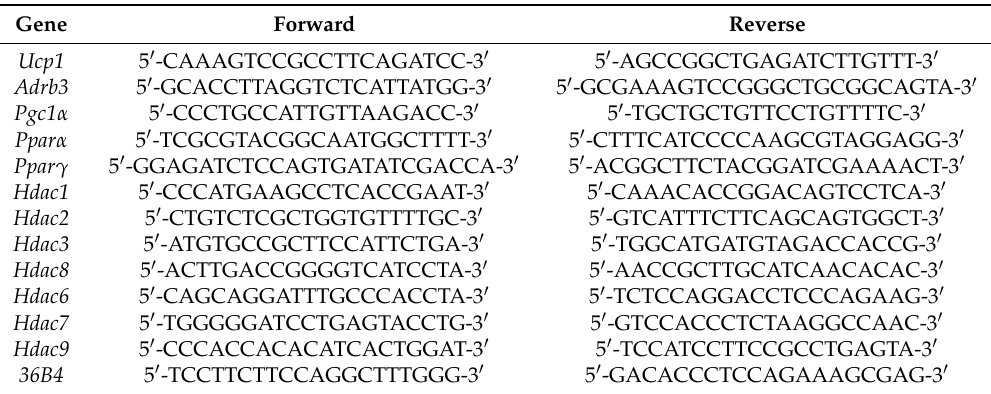
Table 1. Primers used for RNA